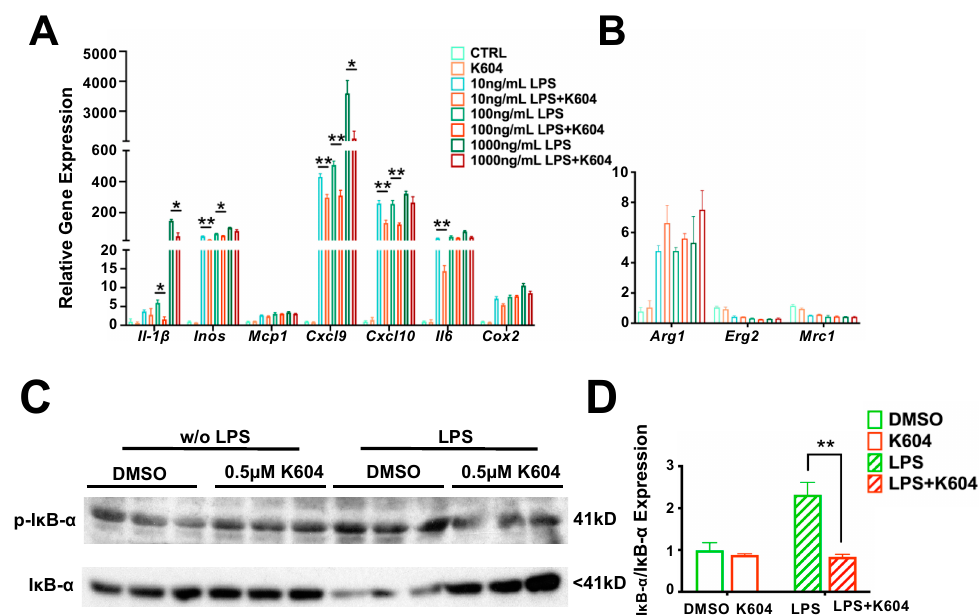
Figure 3. Inhibiting ACAT1/SOAT1 in N9 microglial cell line ameliorates pro-inflammatory re- sponses towards LPS. N9 microglial cells were seeded at 1 × 10 5 cells per well onto 12-well plates in medium RPMI-1640 with 10% serum. N9 cells were treated with DMSO (control group) or 0.5 µ M ACAT1/SOAT1 inhibitor K-604 for 4 h, then treated with 10, 100 or 1000 ng/mL LPS as indicated. After 6 h, mRNAs were extracted, and real-time PCR was performed for ( A ) pro-inflammatory or ( B ) anti-inflammatory gene expressions. ( C ) N9 cells were treated with DMSO (control group) or 0.5 µ M K-604 for 4 h, then treated with or without 100 ng/mL LPS for 30 min. Whole cell pro- teins were used for Western blot to monitor phosphorylation status of I κ B- α according to Section 4. ( D ) Western blot quantification for ratio of p-I κ B- α /I κ B- α . n = 3 replicates. * p < 0.05; ** p <